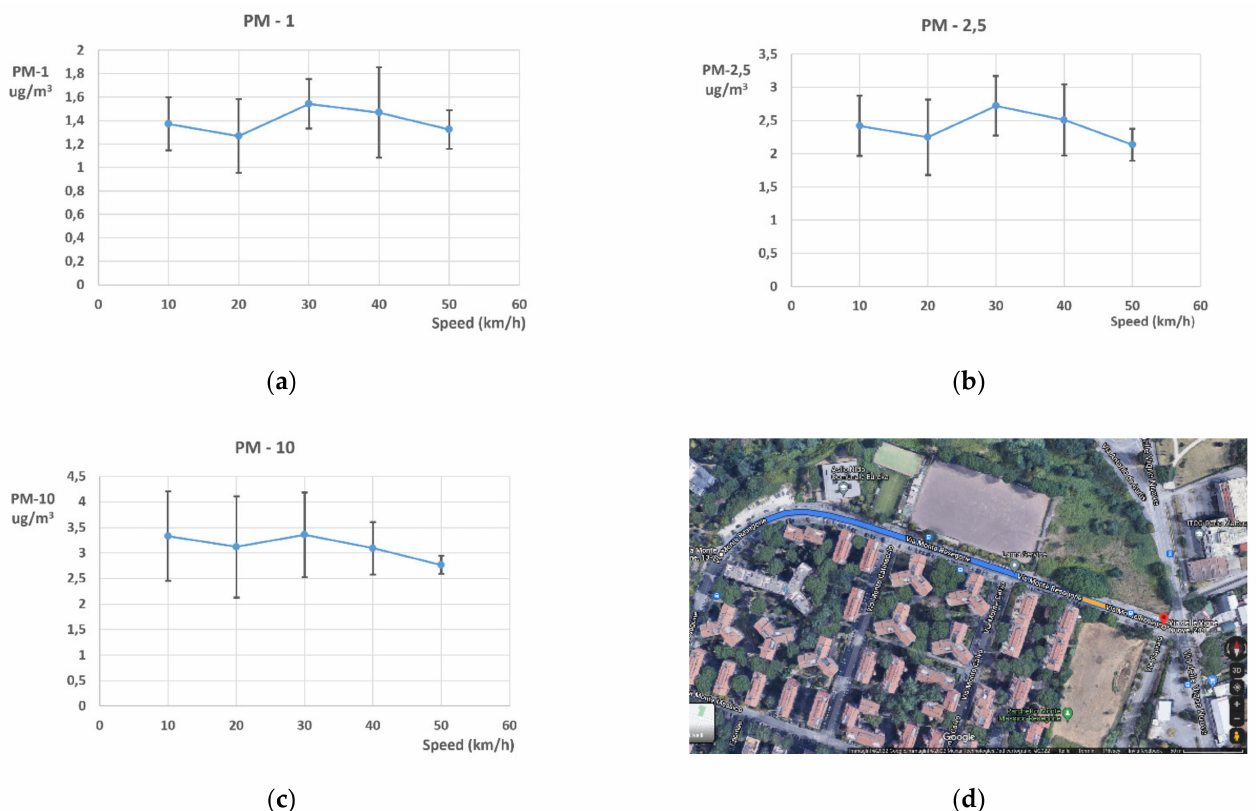
Figure 5. PM sensor measurements as a function of velocity (the error bars are standard deviations): ( a ) PM-1; ( b ) PM-2.5; ( c ) PM-10; ( d ) the trajectory along which the data were